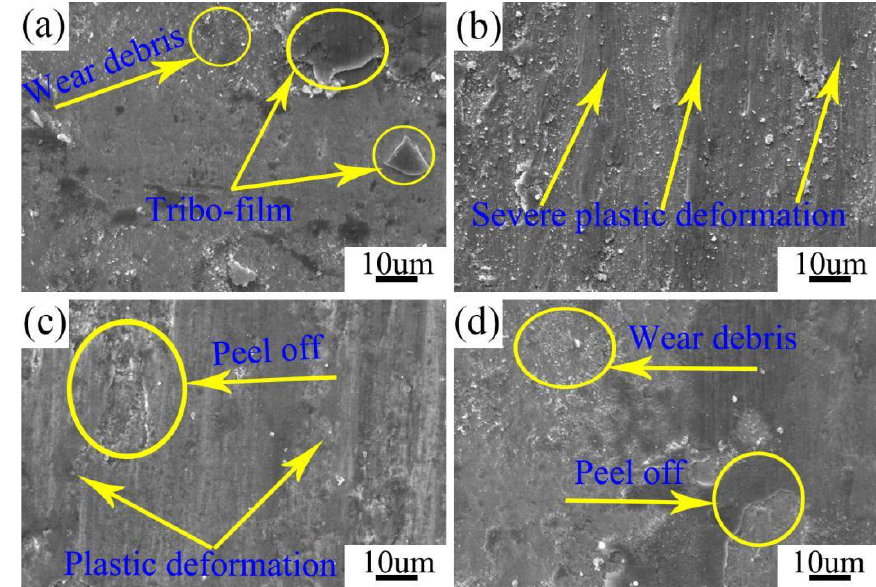
Figure 7. SEM images of the wear scratch: ( a ) 25 °C; ( b ) 500 °C; ( c ) 600 °C; ( d ) 700 °C.